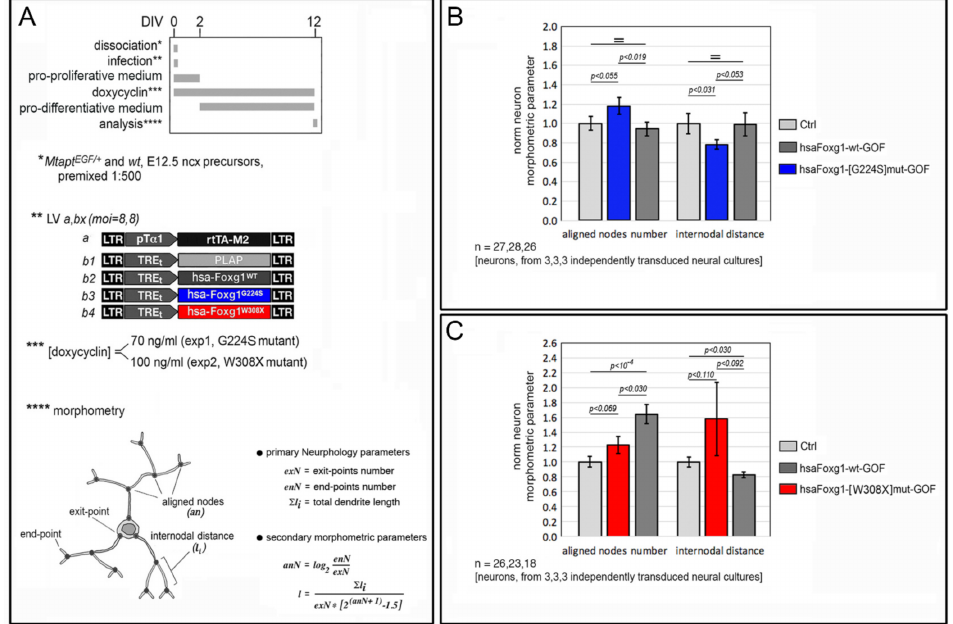
Figure 3. Impact of mutant FOXG1 alleles on neuronal architecture. Protocols in ( A ), results in ( B , C ). Briefly, upon lentiviral engineering, Mapt EGFP/+ neural cells were co-cultured with an excess of co-engineered/non-fluorescent neural cells, and then analyzed as follows: (1) Mapt EGFP/+ neurons were profiled by α EGFP/ α NF immunofluorescence; (2) pictures were skeletonized by Simple Neurite Tracer; (3) primary morphometric indices, exN (exit-points number), enN (end-points number) and ∑ l i (total dendrite length), were extracted by neurphology; (4) secondary indices, average anN (aligned nodes number) and average l (internodal distance), were calculated by Excel, as shown. Finally, results were averaged and statistically evaluated. Shown are data normalized against Plap -expressing controls (absolute anN Plap = 1.91 ± 0.11 and 1.31 ± 0.08, in exp1 and exp2, respectively;